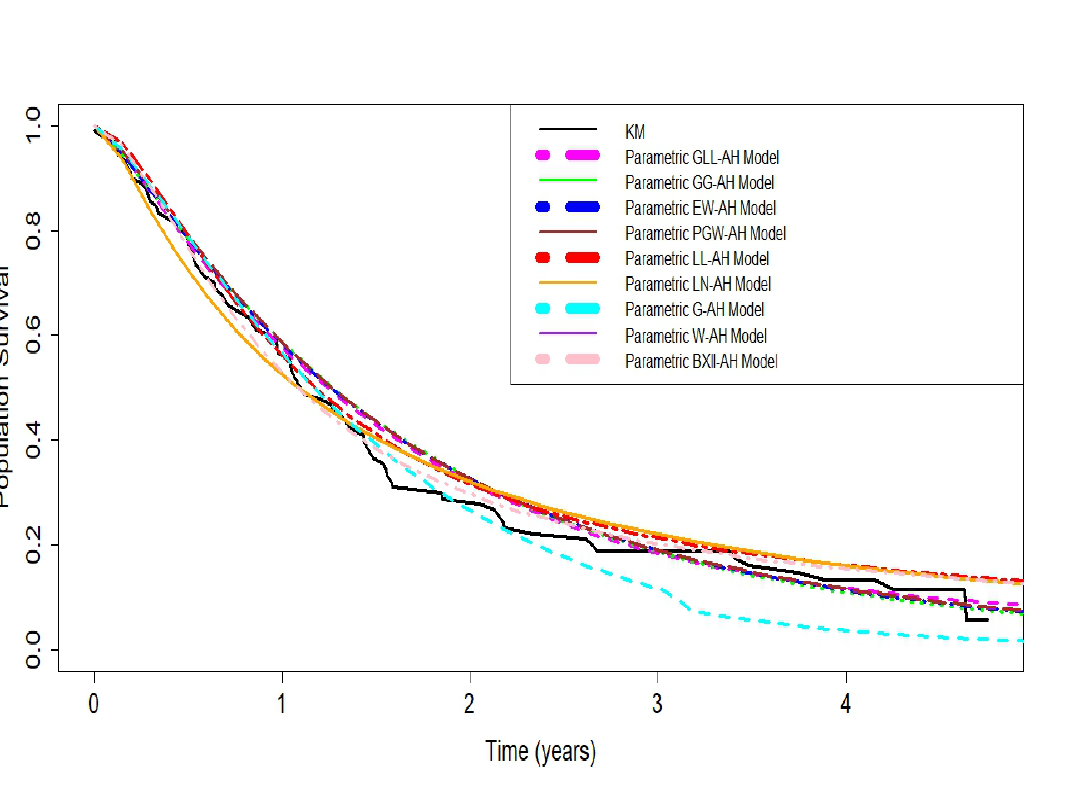
Figure 15. Kaplan–Meier and estimated survival plots for the competitive AH models of the gastric cancer